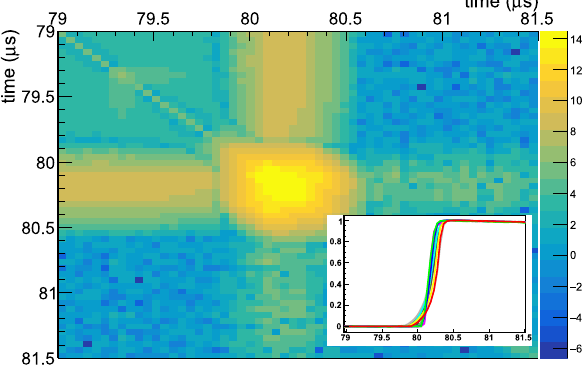
This matrix can be straightforwardly expressed with the